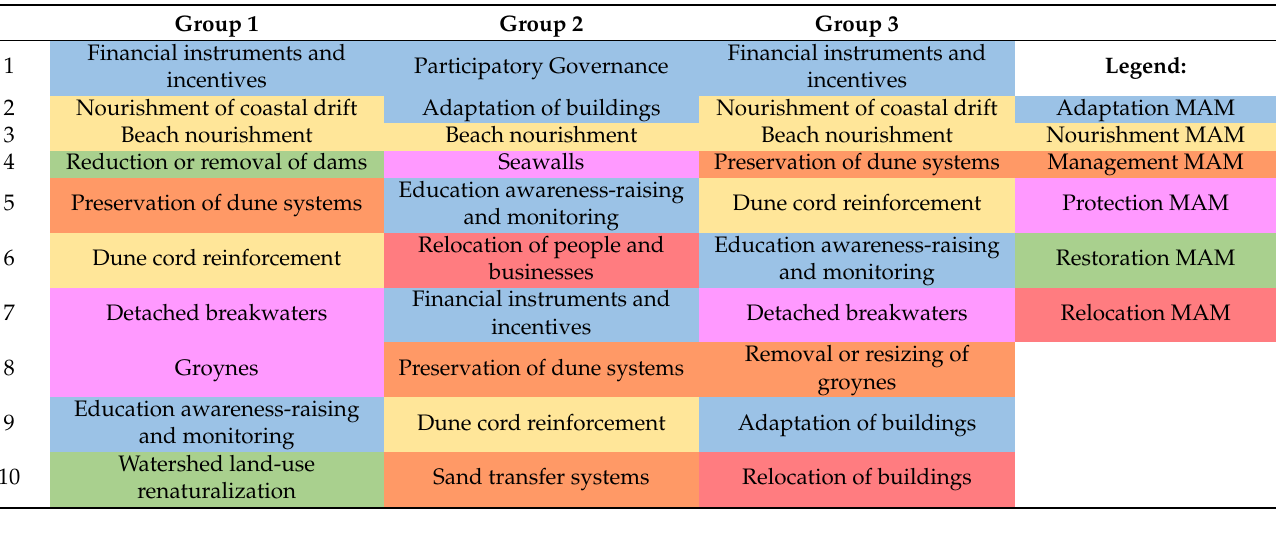
Figure 2. List of major MAM used for this exercise, each with the number of total votes it received from the stakeholders. The 10 most voted measures are highlighted with thicker outlines. Table 2. Prioritization of the previously picked top 10 MAMs from highest (1) to lowest (10) priority, as decided by groups 1, 2, and 3 for a short-term period (2030). The colored cells represent specific types of measures: adaptation (blue), nourishment (yellow), management (orange), protection (purple), restoration (green), and relocation